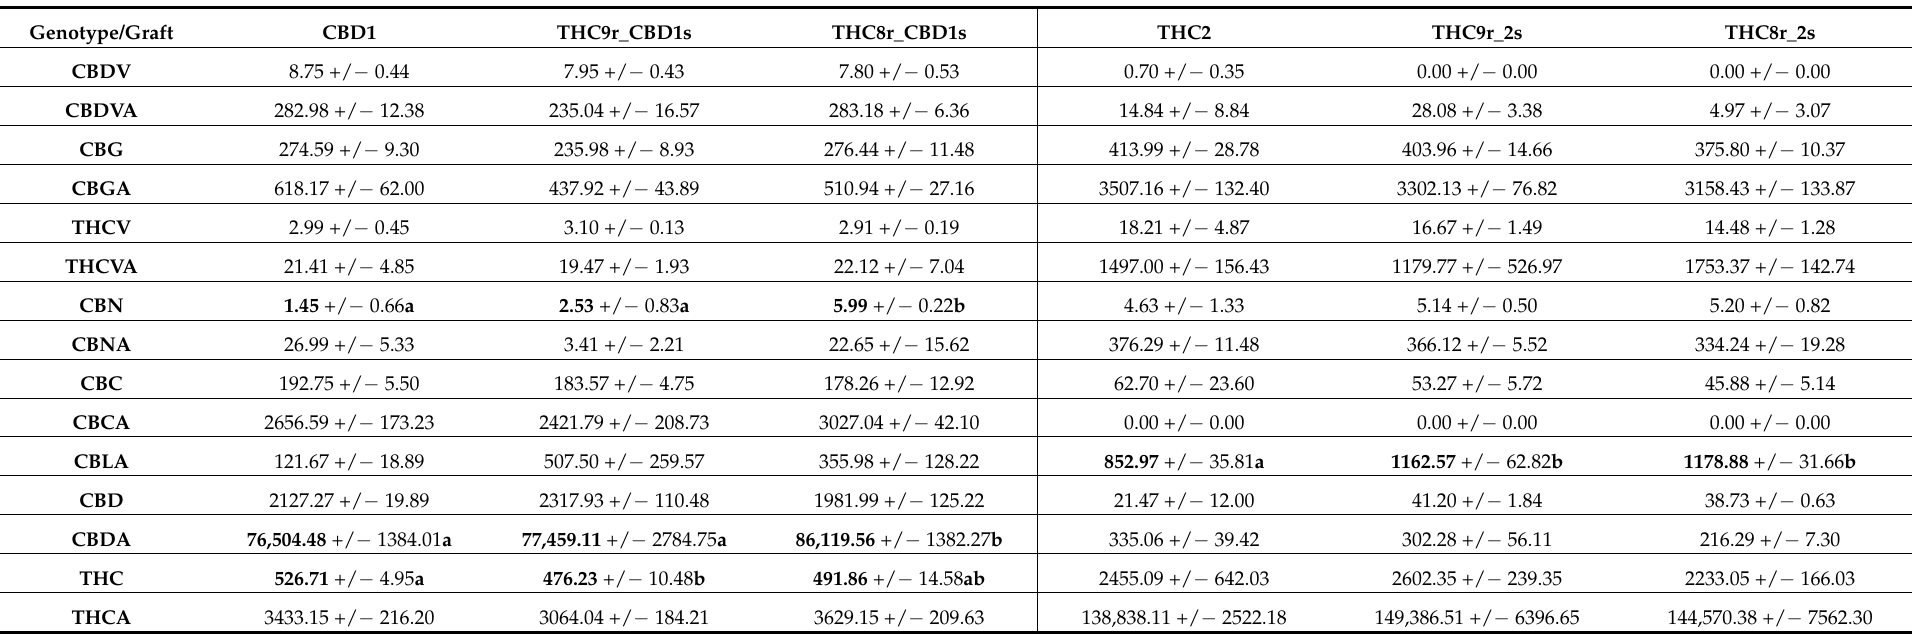
Table 5. Concentration of cannabinoids ( µ g g DW) in control genotypes and grafted scions. N = 3–4 +/ − = SE. Values shown in bold and letters below them denote significant differences between genotypes/grafts (Tukey HSD, p ≤